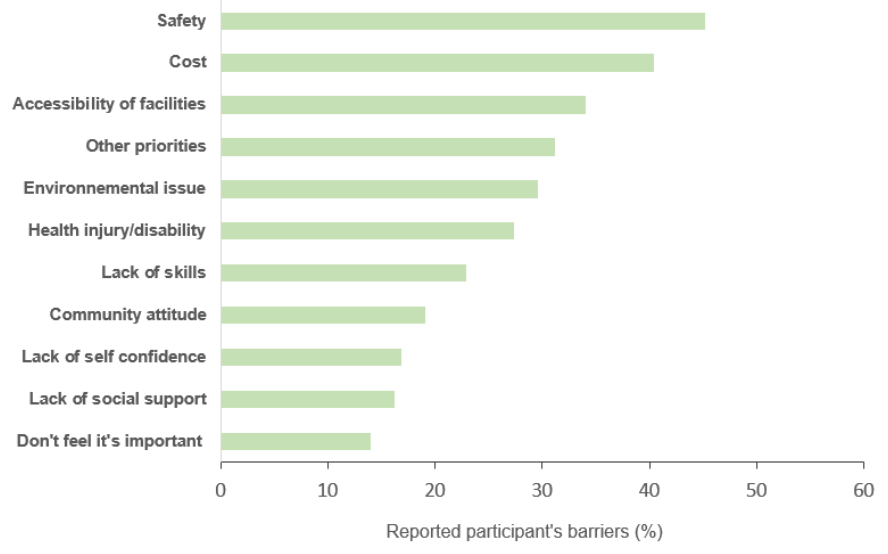
Figure 1. Perceived barriers preventing physical activity participation among at-risk type 2 diabetes black and mixed-ancestry communities, Cape Town, 2018 (N = 316, NA = 2).